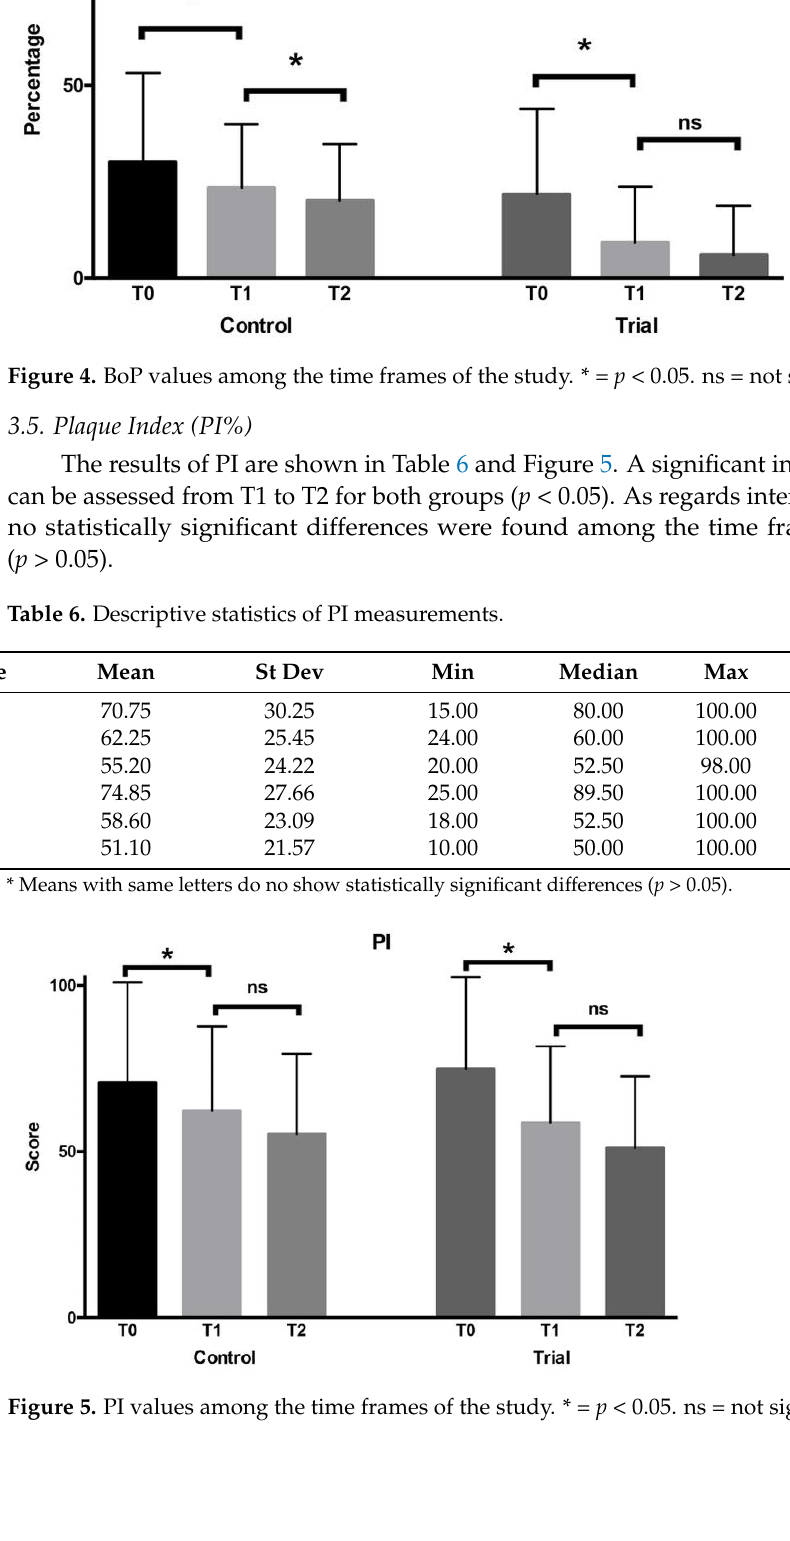
Table 7. Descriptive statistics of PPD measurements.